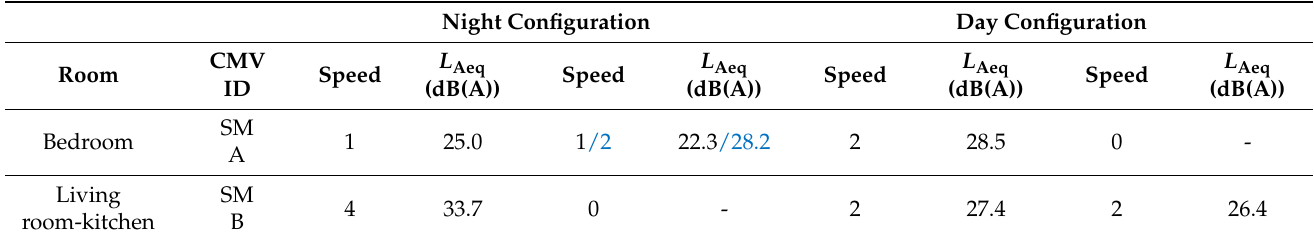
Table 9. Two-room apartment. Night and day configurations (in blue font 0.5 1/h single CMV speed).